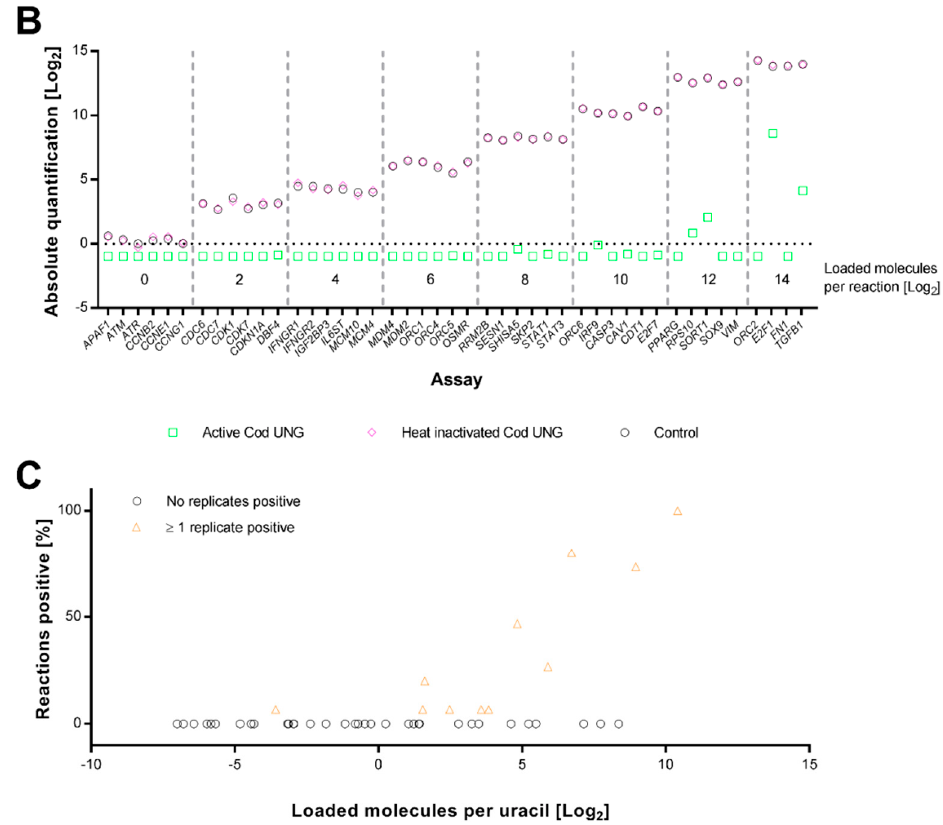
Figure 3. The effect of Cod uracil-DNA N-glycosylase (Cod UNG) treatment on thymine- and uracil-containing DNA standards. ( A ) Cod UNG inhibition test: 43 individual thymine-containing DNA standards were successfully preamplified and analyzed by quantitative real-time polymerase chain reaction (qPCR). Four to six different assays were amplified at each concentration, ranging from 1 to 16,384 molecules per reaction. Prior to preamplification, samples were treated with Cod UNG (green squares), heat inactivated Cod UNG (purple diamonds), or water (control, black circles). Numbers on the x-axis correspond to the number of molecules loaded per reaction, whereas numbers on the y-axis correspond to the number of molecules measured per reaction. The difference in absolute quantities was assessed using the nonparametric Friedman test followed by Dunn’s multiple comparisons test, comparing Cod UNG treatment and heat inactivated Cod UNG treatment with the control group. No statistical significance between Cod UNG and water, nor between heat inactivated Cod UNG and control, was observed ( n = 15 reactions per treatment). ( B ) Cod UNG efficiency test: 45 individual uracil-containing DNA standards were successfully preamplified and analyzed by qPCR. 4 to 6 different assays were amplified at each concentration, ranging 1 to 16,384 molecules per reaction. Prior to preamplification, samples were treated with Cod UNG (green squares), heat inactivated Cod UNG (purple diamonds) or water (control, black circles). Numbers on the x-axis correspond to the number of molecules loaded per reaction. Numbers on the y-axis correspond to the number of molecules measured per reaction. The difference in absolute quantities was assessed using the nonparametric Friedman test, followed by Dunn’s multiple comparisons test, comparing Cod UNG and heat inactivated Cod UNG treatment with the control group. No statistical difference between heat inactivated Cod UNG and control was observed, whereas Cod UNG displayed significantly lower yield than control ( p < 0.0001, n = 15 reactions per treatment). ( C ) Uracil-containing DNA standards positive after Cod UNG treatment. Percentage of positive samples plotted against number of loaded molecules per uracil, the last calculated at total number of uraciles in the sequence between the primers. For example, the E2F1 assay was loaded with 16,384 DNA standard molecules and the amplicon contained 12 uraciles, i.e., 16,384/12 = 1365 loaded molecules per uracil. Each black circle and orange triangle corresponds to one assay ( n = 15 replicates per assay).